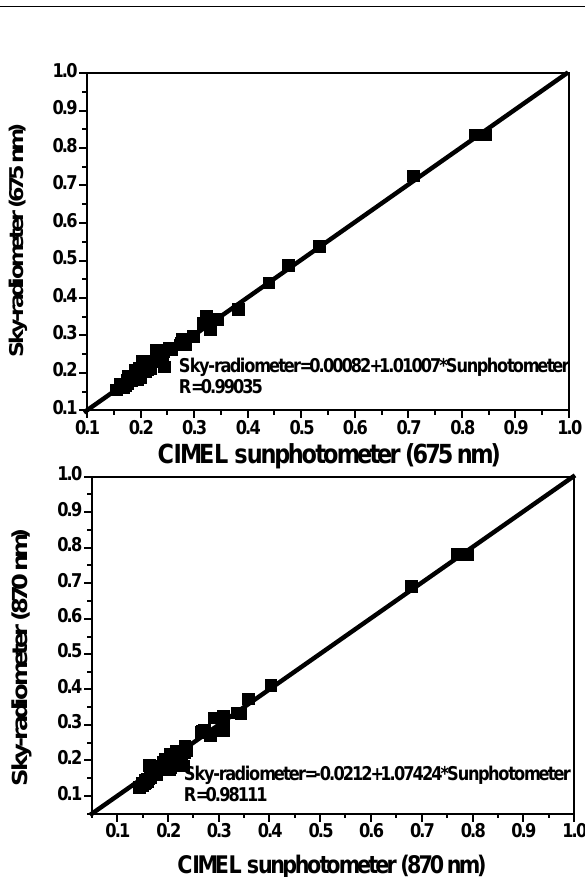
Fig. 1. AOD measured by POM-01 versus CIMEL in MAM at SACOL.